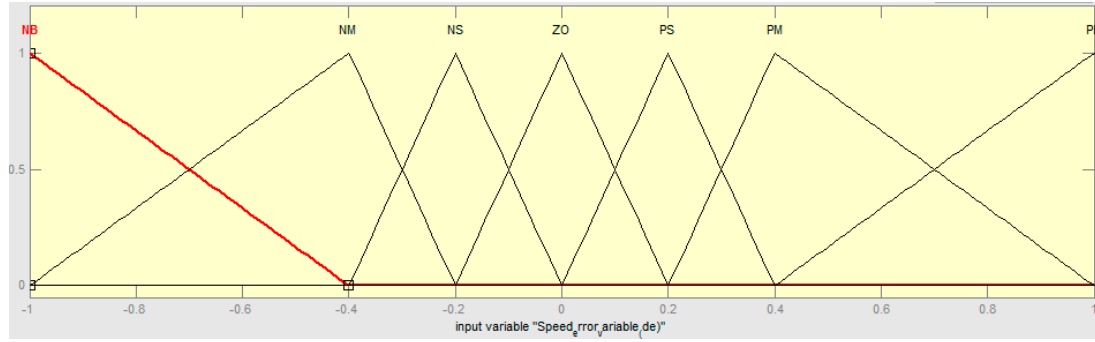
Figure 14. Membership function of speed error variable (de) optimized by PSO.